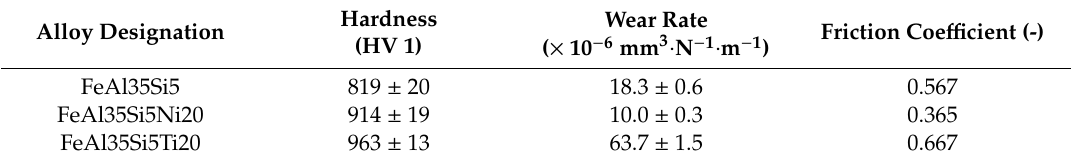
Table 3. Hardness, wear rate and friction coe ffi cient of tested bulk